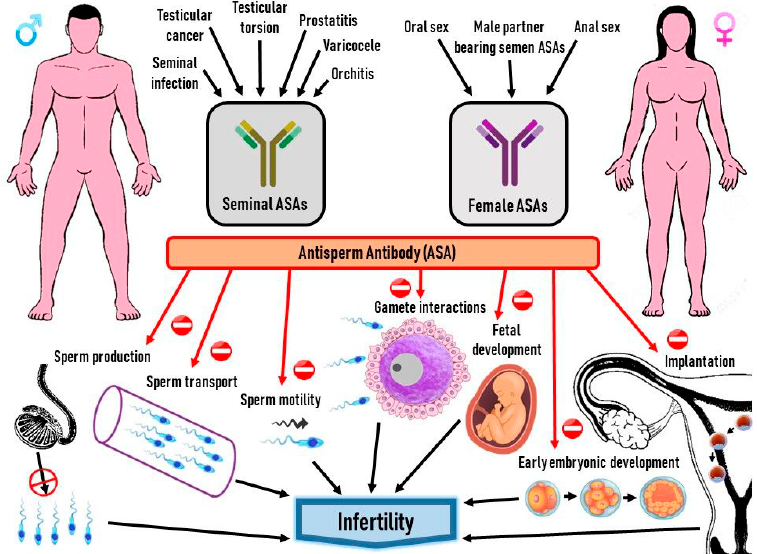
Figure 2. Production of antisperm antibodies and the mechanisms of action in the female reproductive tract that lead to